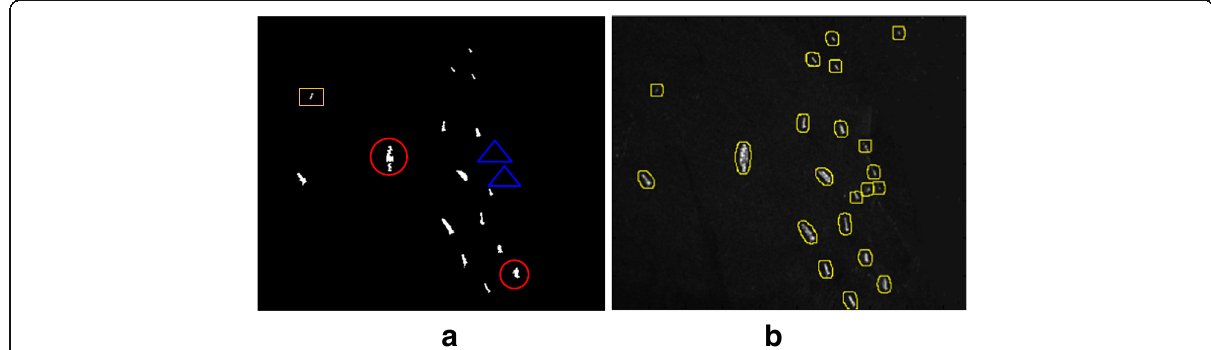
Fig. 9 Detection results for comparison. a Detection result of the VWIE algorithm. b Detection result of the VA-SVD